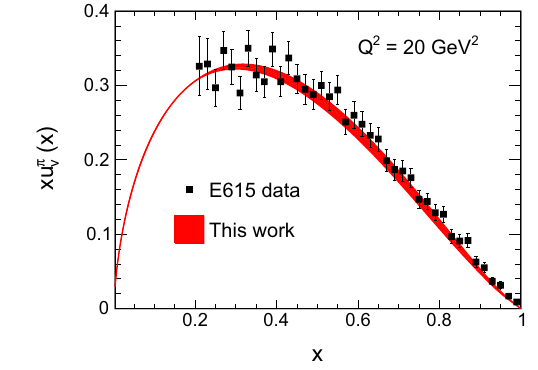
Fig. 2 Comparisons of our predicted up valence quark distribution of the pion with E615 experimental data [28]. The error band of this work shows the 3 σ uncertainty of the valence distribution